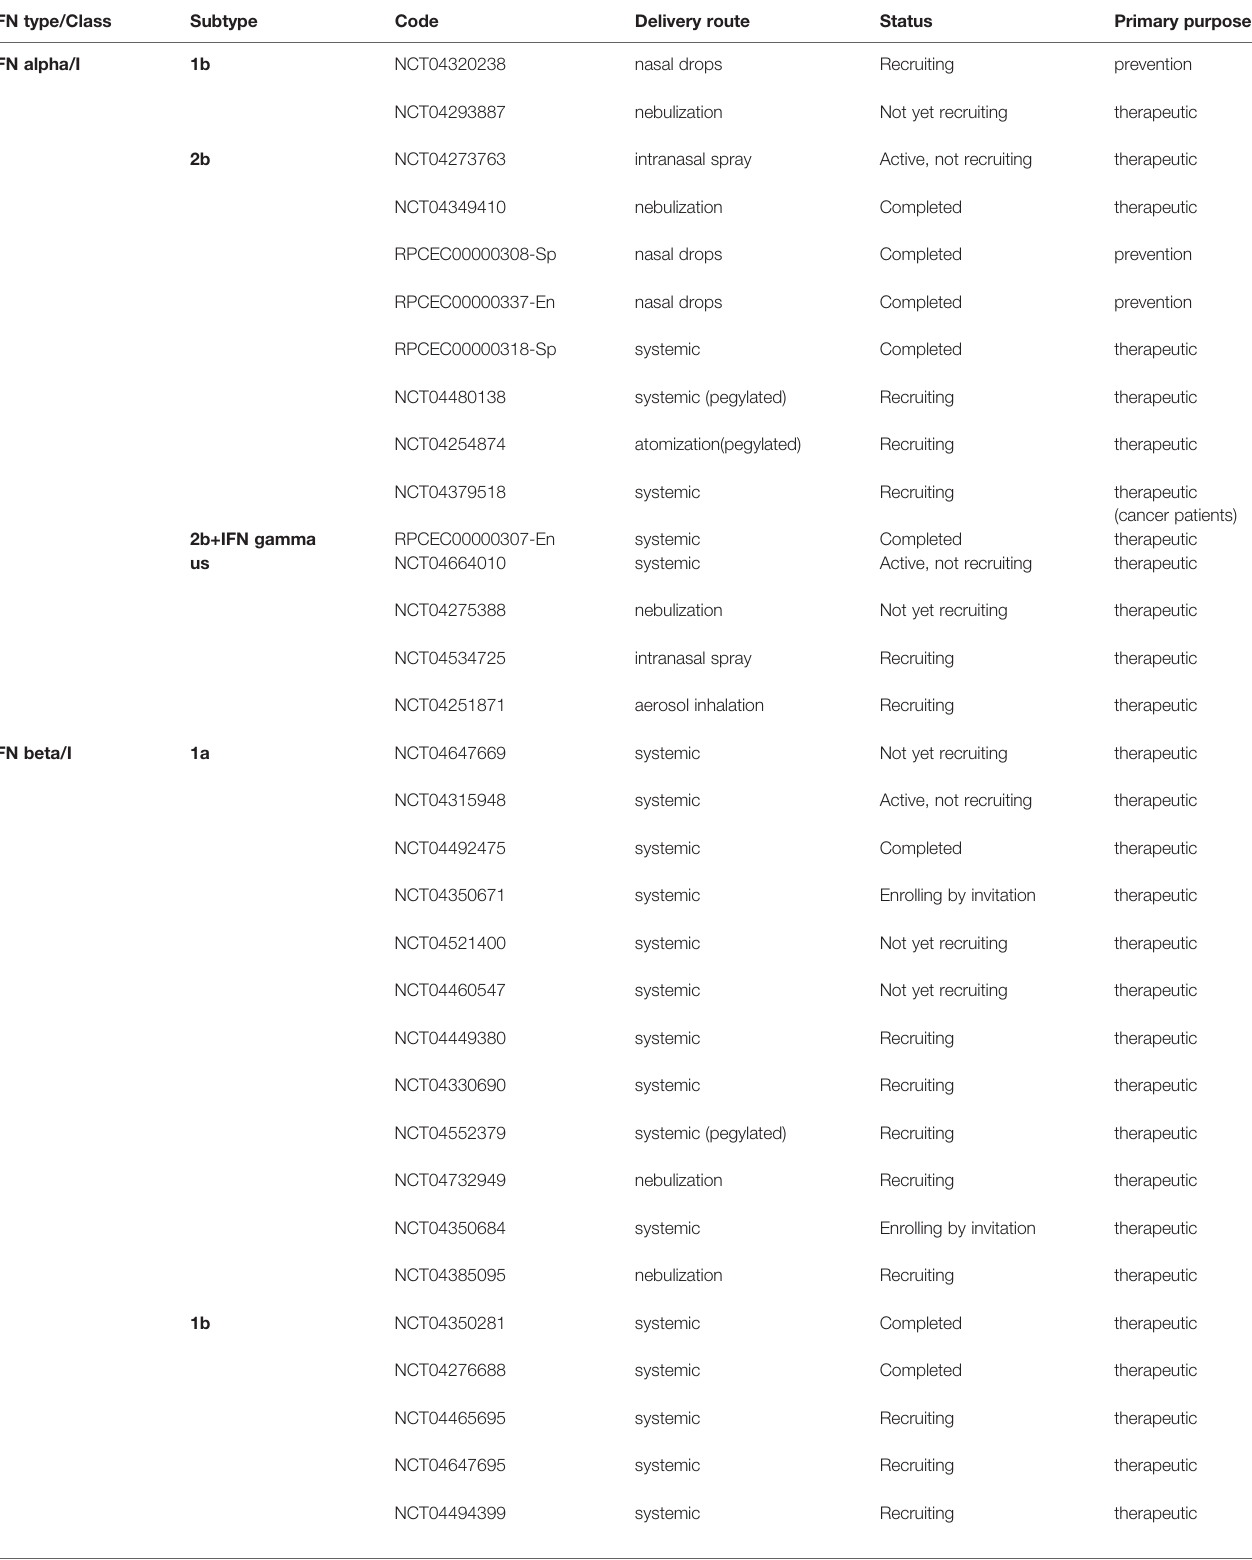
TABLE 1 | Current clinical trials based on Interferons for